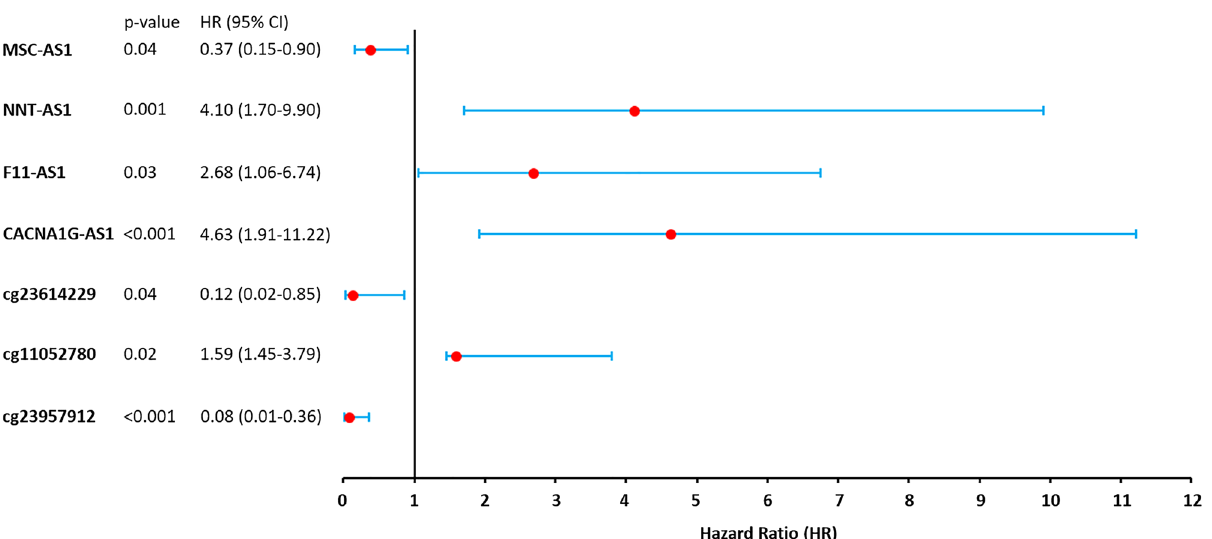
Figure 5. Forest plot showing the correlation between the methylation of DMCs and expression of DElncRNAs with the overall survival of the Prostate cancer patients. Median beta value for the DMCs and the median FPKM value for the lncRNAs were considered as cut-off